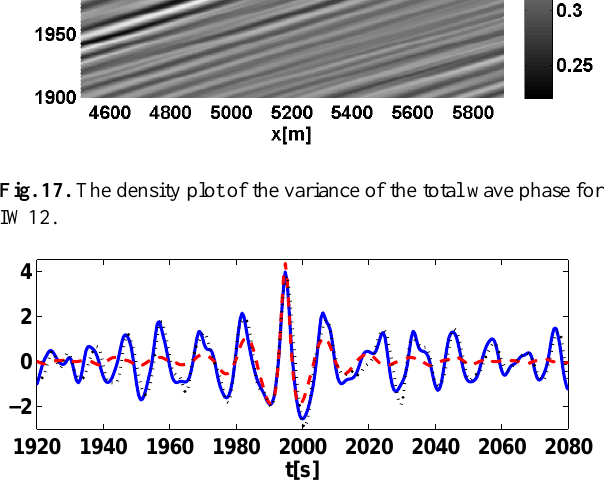
Fig. 18. Time signal as calculated by nonlinear AB at focussing position (solid), nonlinear pm-wave predicted from time signal at X obs (dashed), and Signal prediction (dotted line) for IW12. difficult to be identified in the density plot of the phase